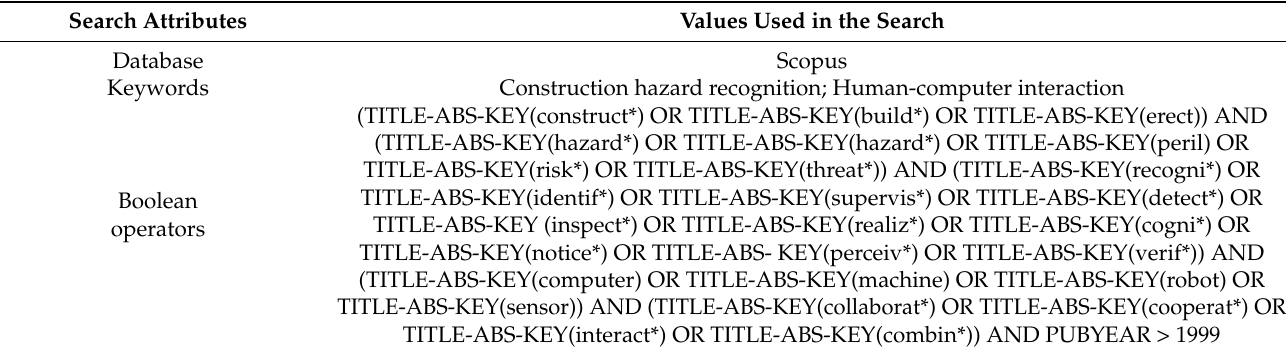
Table 1. An example of paper